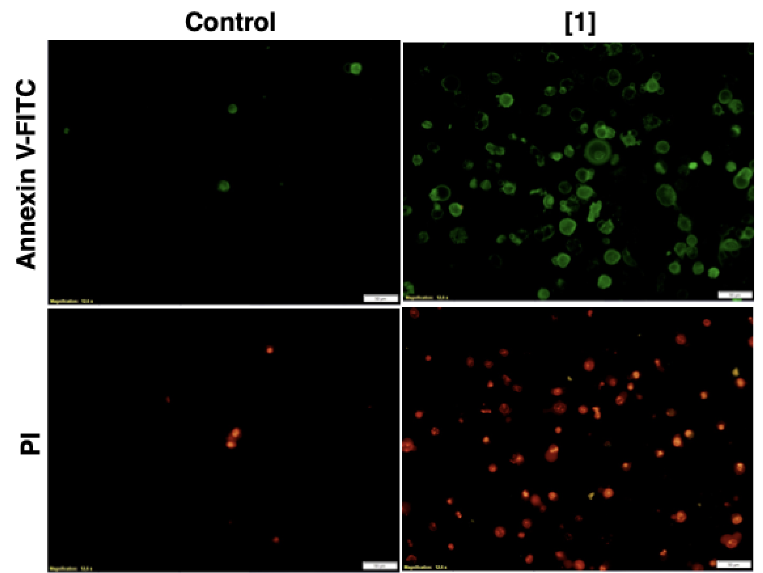
Figure 4. Fluorescence microscopy analysis of Annexin V-FITC staining. A549 lung cancer cells were seeded into an 8-well chamber slide (Millipore, Germany) at a density of 5×10 4